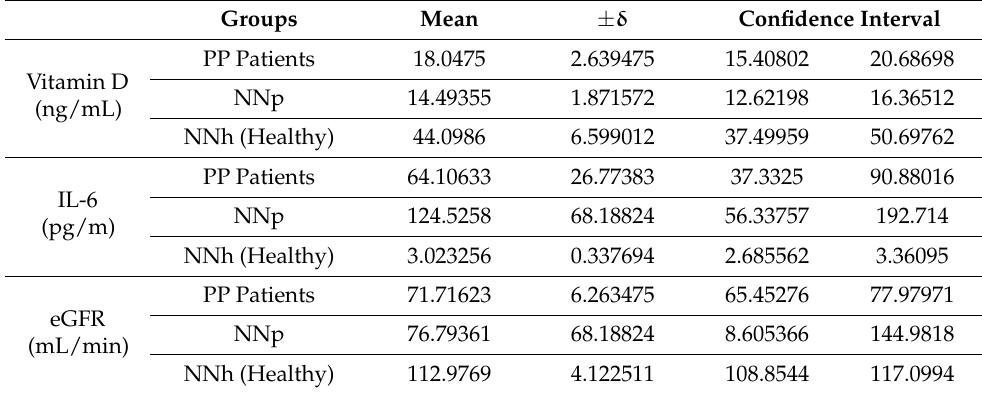
Table 1. Mean values of vitamin D, IL-6, and eGFR for three groups, together with their respective confidence intervals with the confidence level 95%.